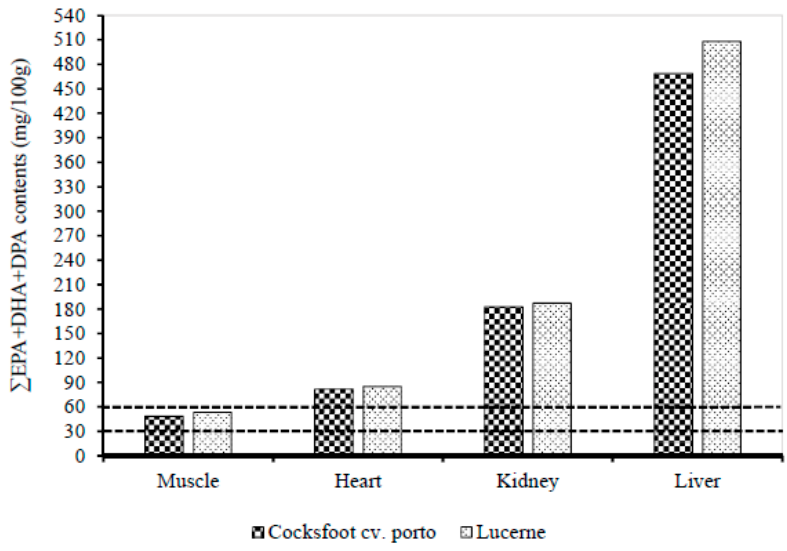
Figure 2. Effect of two different pasture types (cocksfoot cv. porto and lucerne) on the contents of ∑ EPA + DPA + DHA in Longissimus dorsi muscle, heart, kidney, and liver. EPA, eicosapentaenoic acid; DHA, docosahexaenoic acid; DPA, docosapentaenoic acid. The lines at 30 and 60 mg/100 g represent “source” and “good source” of omega-3 FA